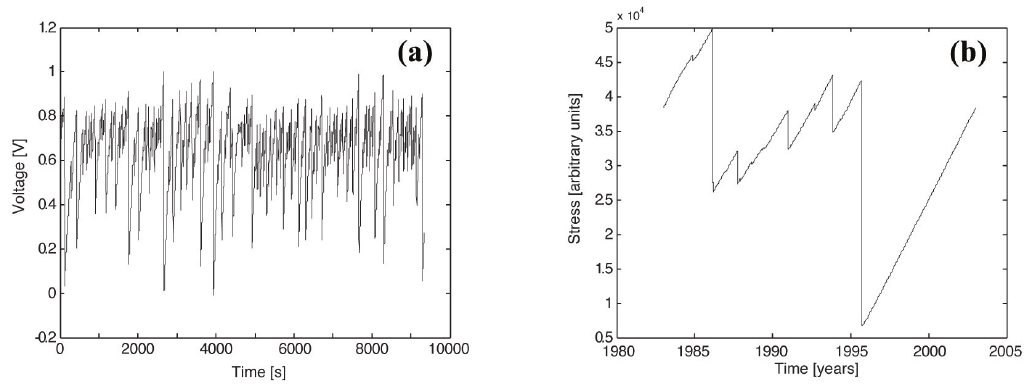
Figure 3. (a) Extracts of the time series obtained by monitoring the earthquake machine at a rate of 10 samples per second. (b) Time series reconstructed from 20 years (1980-2000) of SAF seismicity.